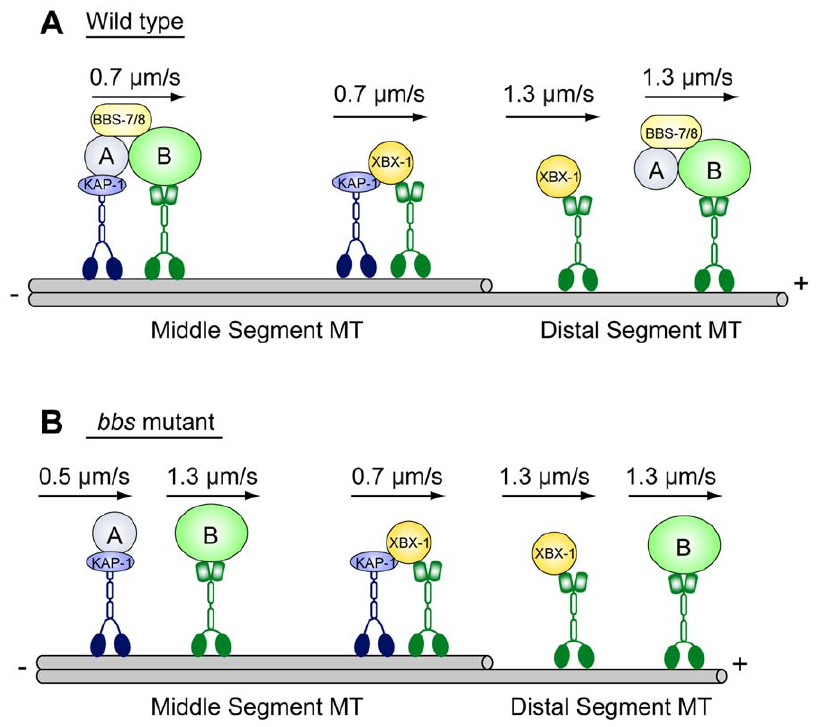
Figure 4. A model for XBX-1::YFP anterograde transport in C.elegans sensory cilia. (A) In wild type, XBX-1::YFP, likely associated with an IFT-dynein heavy chain, is transported separately from IFT particles by the coordinate action of the two IFT anterograde motors, kinesin-II and OSM-3, in the middle segment and by OSM-3 alone in the distal segment. (B) In bbs mutants, the transport of XBX-1::YFP is the same as in wild type, while the two IFT-A and IFT-B subcomplexes are separated and transported by kinesin-II and OSM-3, respectively.